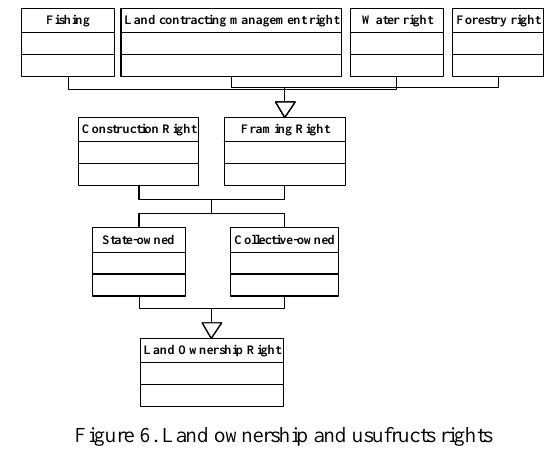
Figure 6. Land ownership and usufructs rights